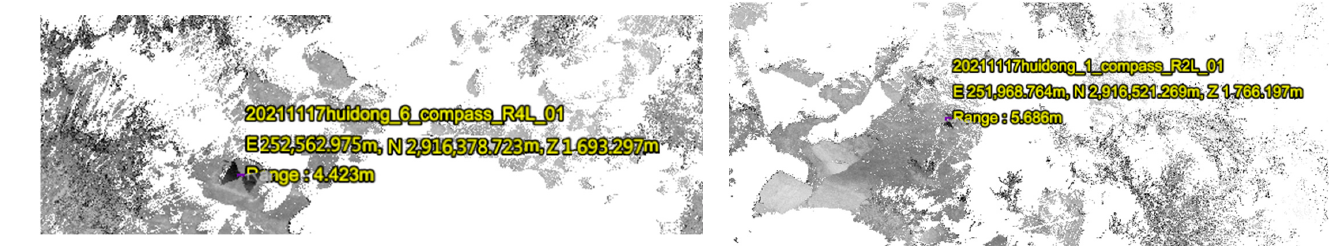
Figure 8. Control target point cloud coordinate query. Table 2. Point cloud rough registration by unified coordinate system method.